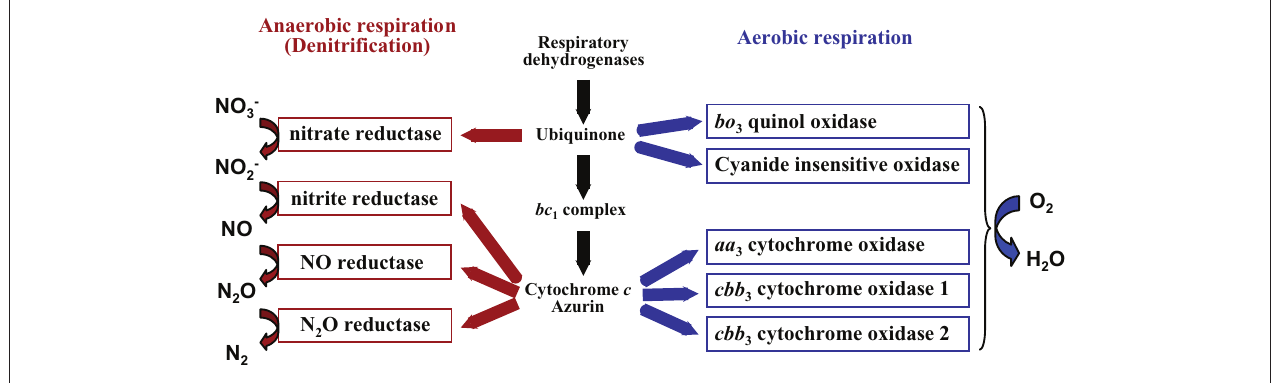
Figure 1 | Branched respiratory chain of P. aeruginosa . Under aerobic conditions, oxygen is utilized as a terminal electron acceptor and reduced to water by five terminal oxidases. Two quinol oxidases, the bo cyanide-insensitive oxidase, receive electrons directly from quinol. Three